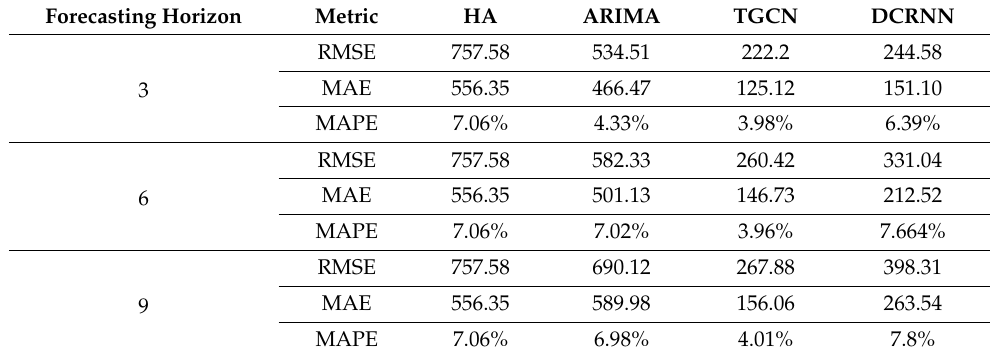
Table 2. Performance comparison for GNN and baseline models on the Greek OGD